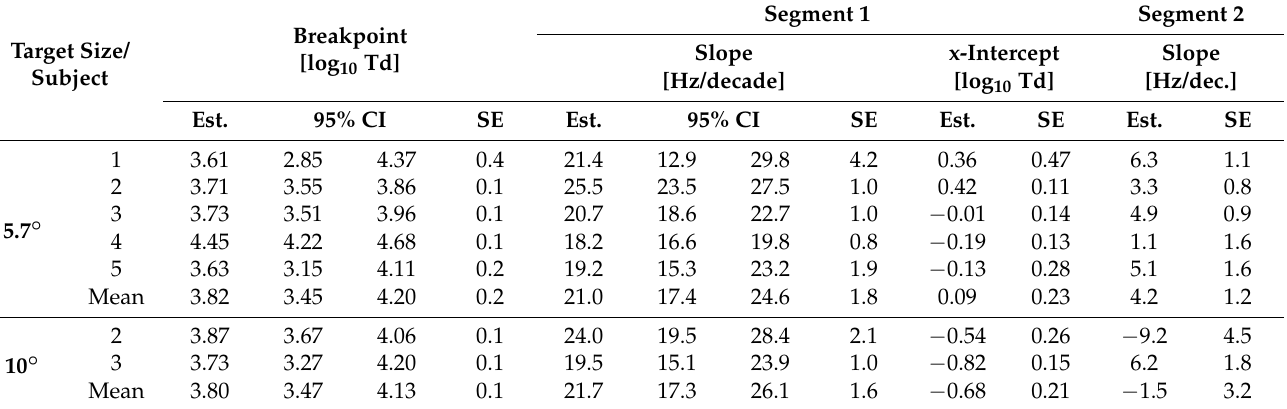
Table 1. Segmented linear regression results of CFF as a function of log10 retinal illuminance for each size of stimuli and subject. The breakpoint is the value of log I at which the piece-wise linear function separates. The estimated values (Est.), their standard errors (SE), and 95% confidence intervals (CI 95%) are shown. The slopes are in units of Hz/decade, and the x-intercept and breakpoint in units of log10